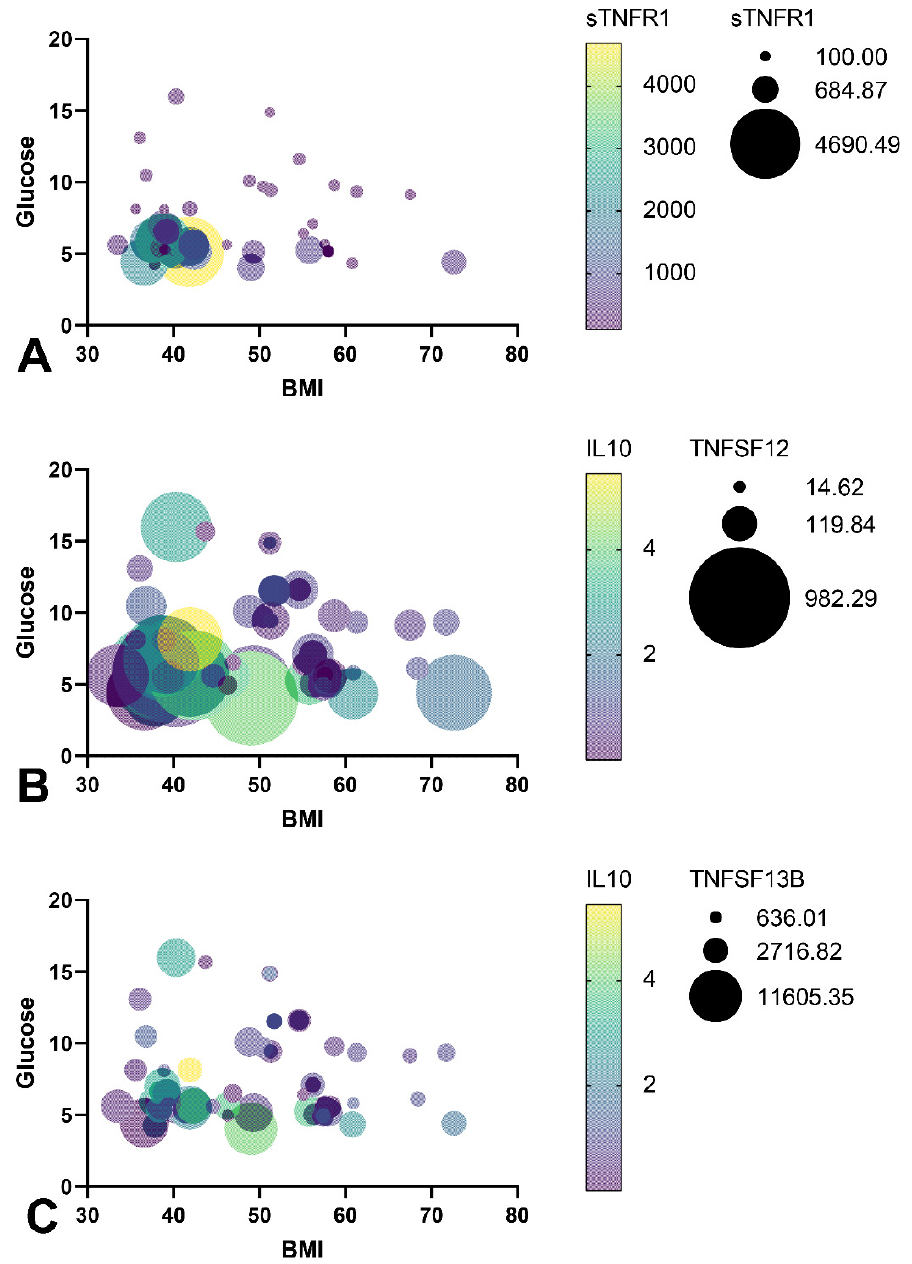
Figure 4. Models of multiple regression analysis of the relationship between the sTNF-R1, TNFSF12, TNFSF13B levels, and glucose level, IL10 level, and BMI (significance p < 0.05). ( A ) sTNF-R1 model of multiple regression; ( B ) TNFSF12 model of multiple regression; ( C ) TNFSF13B model of multiple regression.